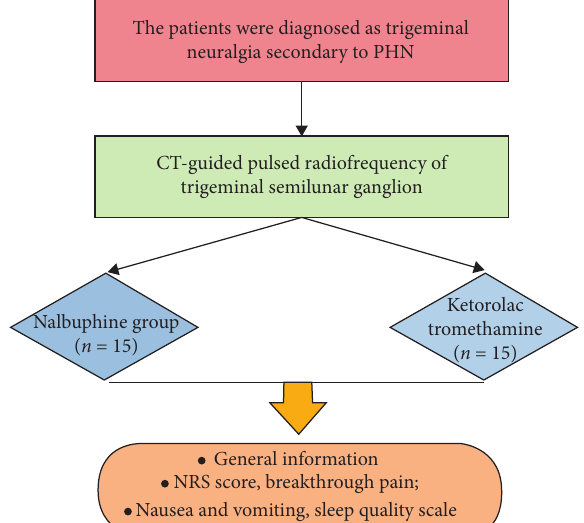
Figure 1: The flowchart of the study. PHN, postherpetic neuralgia; CT, computer tomography; NRS, numeric rating scale.